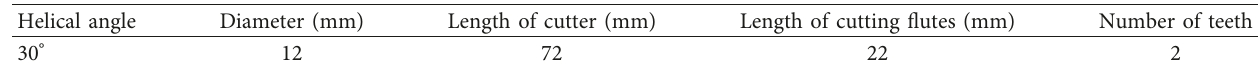
Table 1: Cutter geometry parameters.